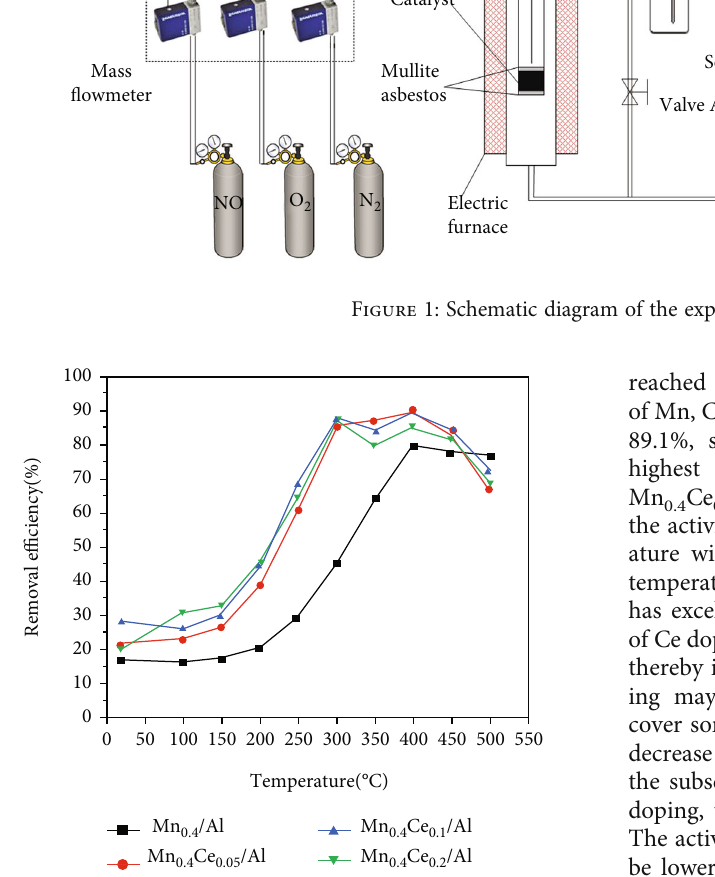
Figure 2: Removal e ffi ciency of catalysts with di ff erent Ce